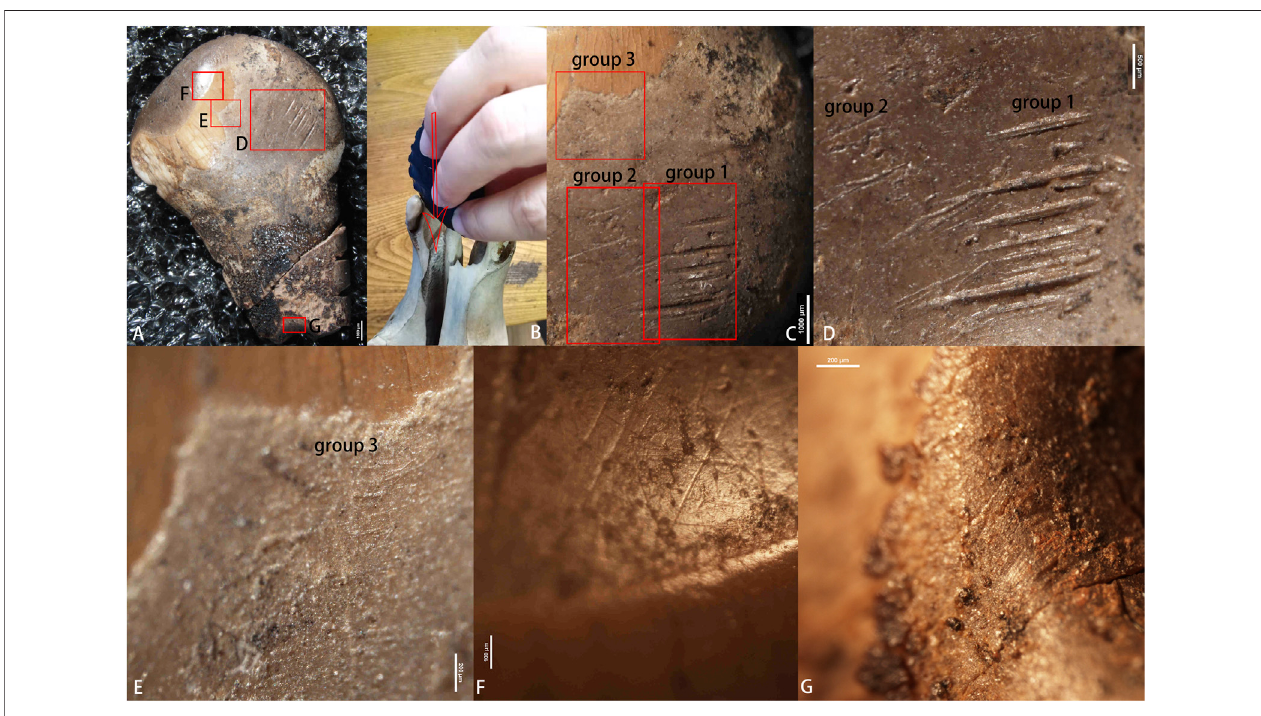
FIGURE3|(A) Locationofthepolish,scrapingandpossibleuse-wear; (B) Imitationofhowscrapingwasproducedonlingualsurfaceofthecanine; (C) Locationof three subgroups of the scraping; (D,E) Close-up view of the scraping; (F) Intense polish associated with multidirectional thin striations on the occlusal surface; (G) Extremely thin striations at the periphery of the perforation. Scales: (A,C) 1,000 μ m, (D) 500 μ m, (E,G) 200 μ m; (F) 100 μ m.